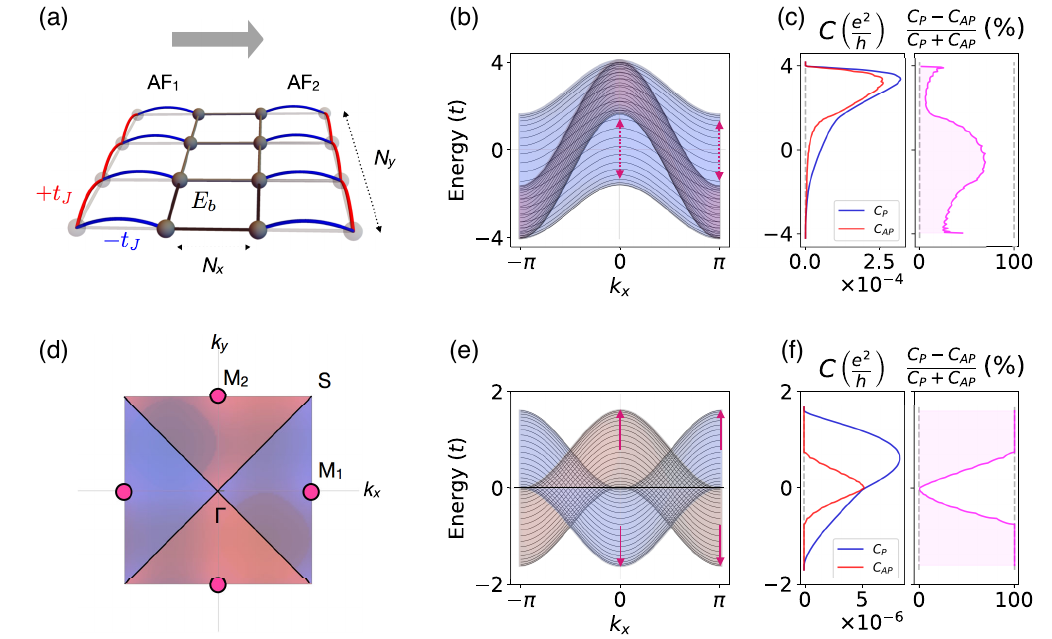
FIG. 2. Model transport calculations in a quasi-two-dimensional tunnel junction. (a) Schematics of the geometry of the leads representing the unconventional antiferromagnets, the scattering region separating the leads (spacer), and selected parameters used in the calculations. (b) Spin-up (red) and spin-down (blue) energy bands in the lead as a function of k x plotted for the discrete set of transverse wave-vector parameters corresponding to N y ¼ 20 lattice points in the direction parallel to the lead-spacer interface. Hamiltonian parameters in the lead correspond to Fig. 1(c) and the first case described in the text. (c) Conductances for parallel (P) and antiparallel (AP) configurations of the N´eel vectors in the leads and the corresponding relative difference of the P and AP conductances. (d) Top view of the energy bands with the alternating spin-momentum coupling in the lead in the first Brillouin zone. Hamiltonian parameters in the lead correspond to Fig. 1(f) and the second case described in the text. Magenta circles mark the alternating spin-polarized valleys. (e),(f) The same as (b),(c) for Hamiltonian parameters in the lead corresponding to Fig. 1(f) and the second case described in the text. In (b),(e), the magenta arrows mark the energy ranges with decoupled spin-up and spin-down channels due to the spin-polarized valleys in the band